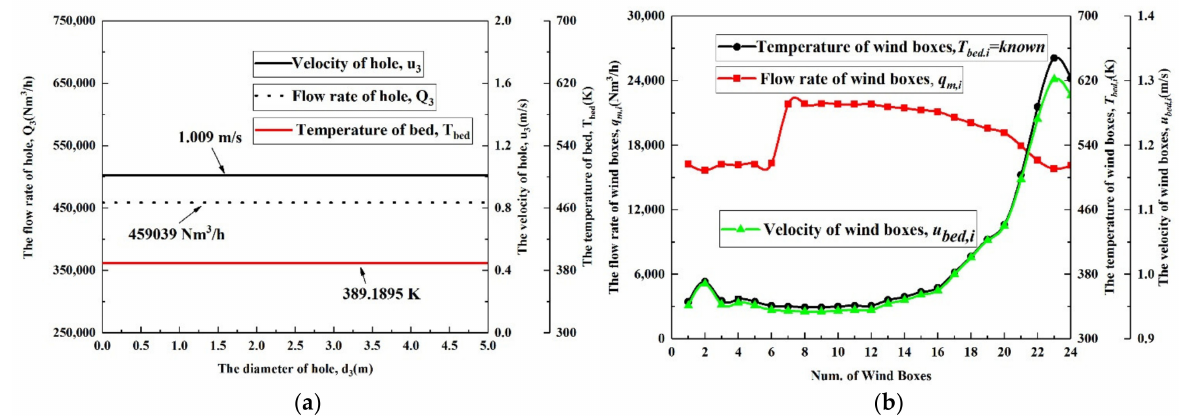
Figure 6. The results of the counter-flow bed model. ( a ) The flow rate, velocity and temperature of holes. ( b ) The flow rate, velocity and temperature of the sintering bed at each wind box